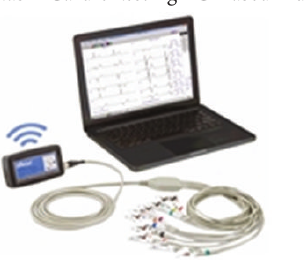
Table 2: Selected featured ECG commercial devices. Nasiff CardioResting PC-Based Bluetooth ECG